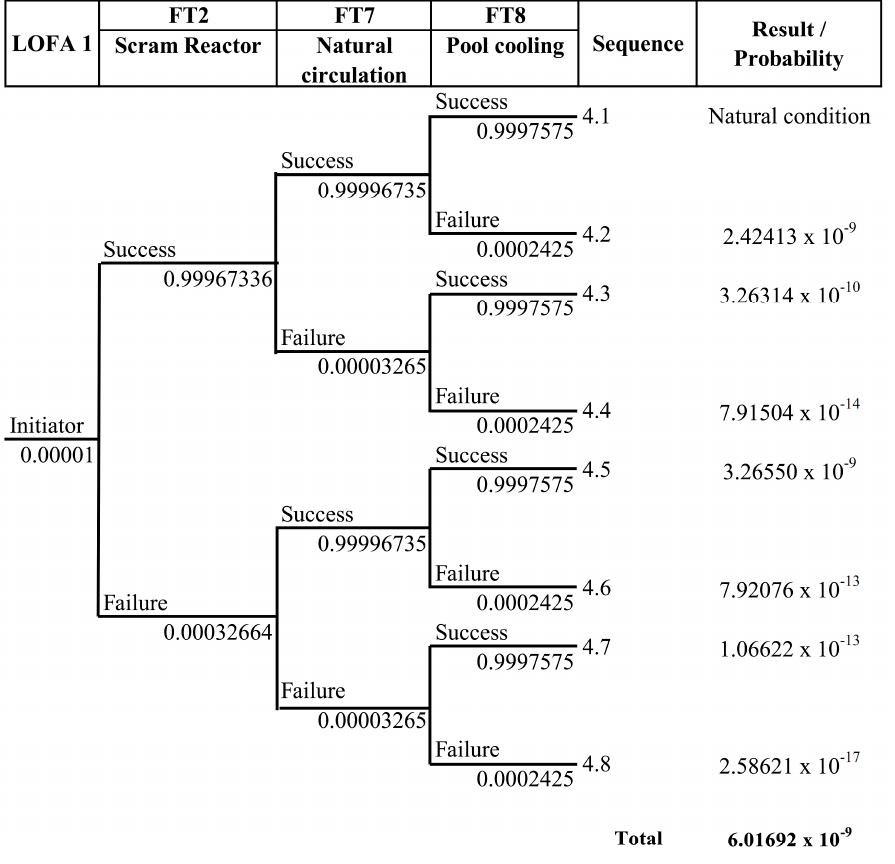
Figure 13. Event tree of LOFA 1.